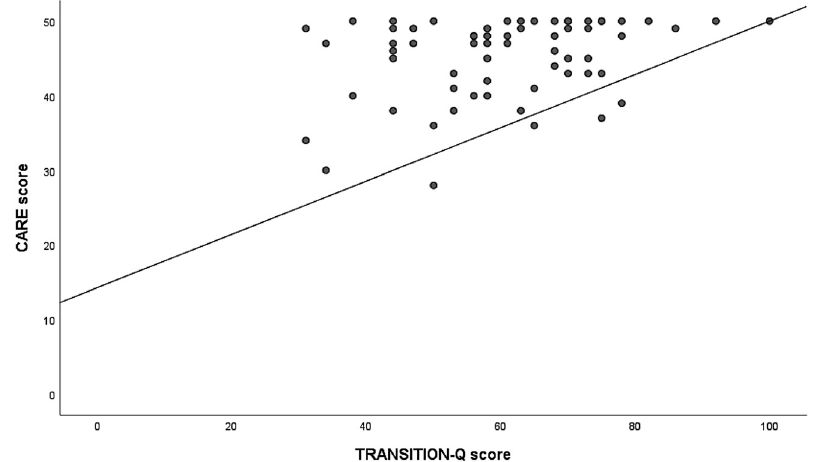
Figure1: AssociationbetweenTRANSITION-Q and CARE